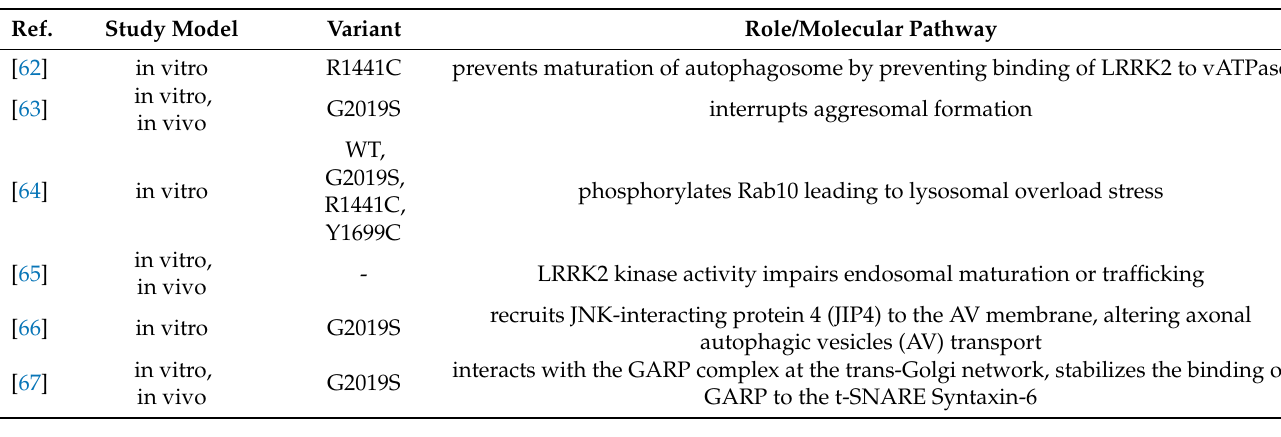
Table 7. LRRK2 contributions to dysfunction in autophagy/lysosome pathways.